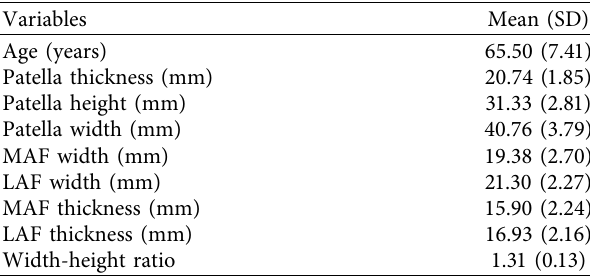
Table 1: Age and dimensions of patellae ( n � 156).